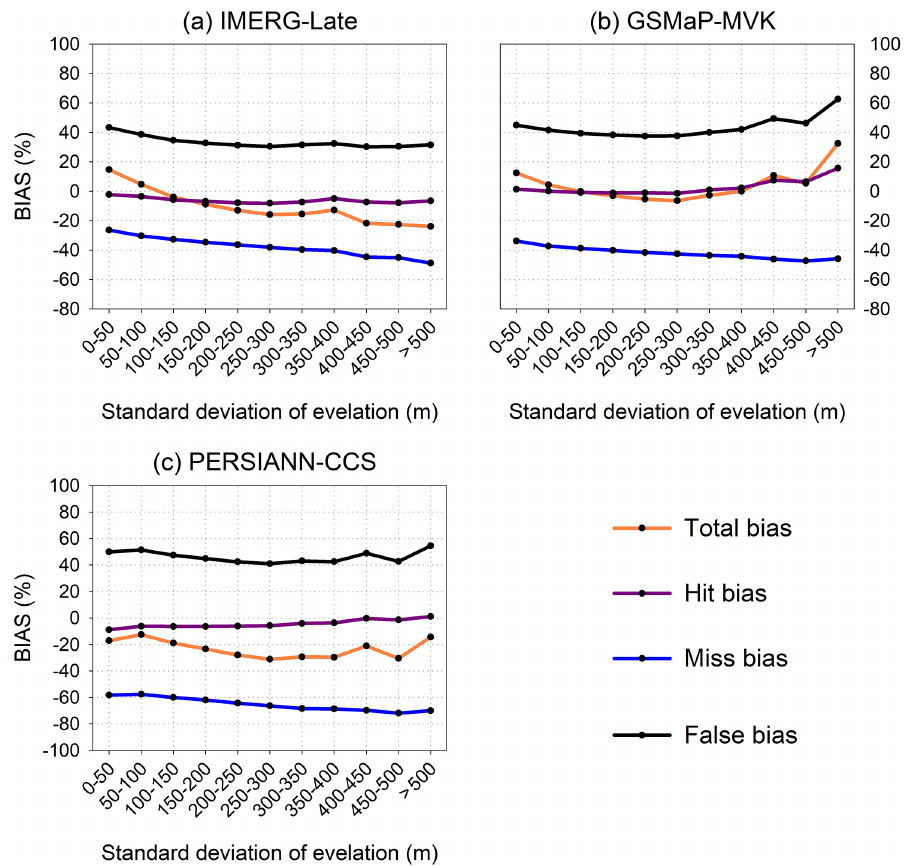
Figure 10. The four bias scores (i.e., total bias, hit bias, miss bias, and false bias) of the three satellite-only global precipitation estimates (i.e., IMERG-Late, GSMaP-MVK, and PERSIANN-CCS) for different terrains. Note that the analysis was executed at a spatial resolution of 0.1 ◦ and hourly temporal resolution in the humid regions of mainland China over the JJA (summer) season for the period from 2015 to 2019